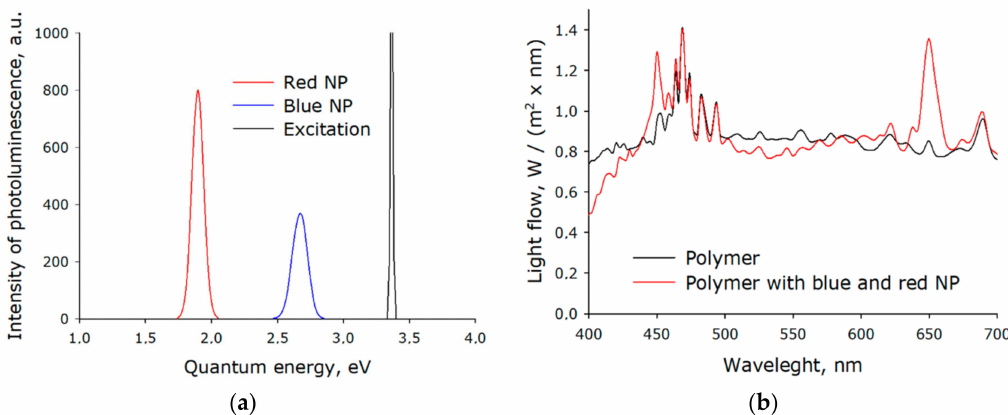
Figure 2. The photoluminescence spectrum of photoconversion nanoparticles. ( a ) Photoluminescence spectrum of photoconversion nanoparticles in acetone. Red NP-fluorophore nanoparticles with emission in the red region of the spectrum. Blue NP-fluorophore nanoparticles with blue emission. ( b ) The photoluminescence spectrum of a fluoropolymer containing and not containing photoconversion nanoparticles. Luminescence was excited with a xenon lamp and a diode source (375 nm).